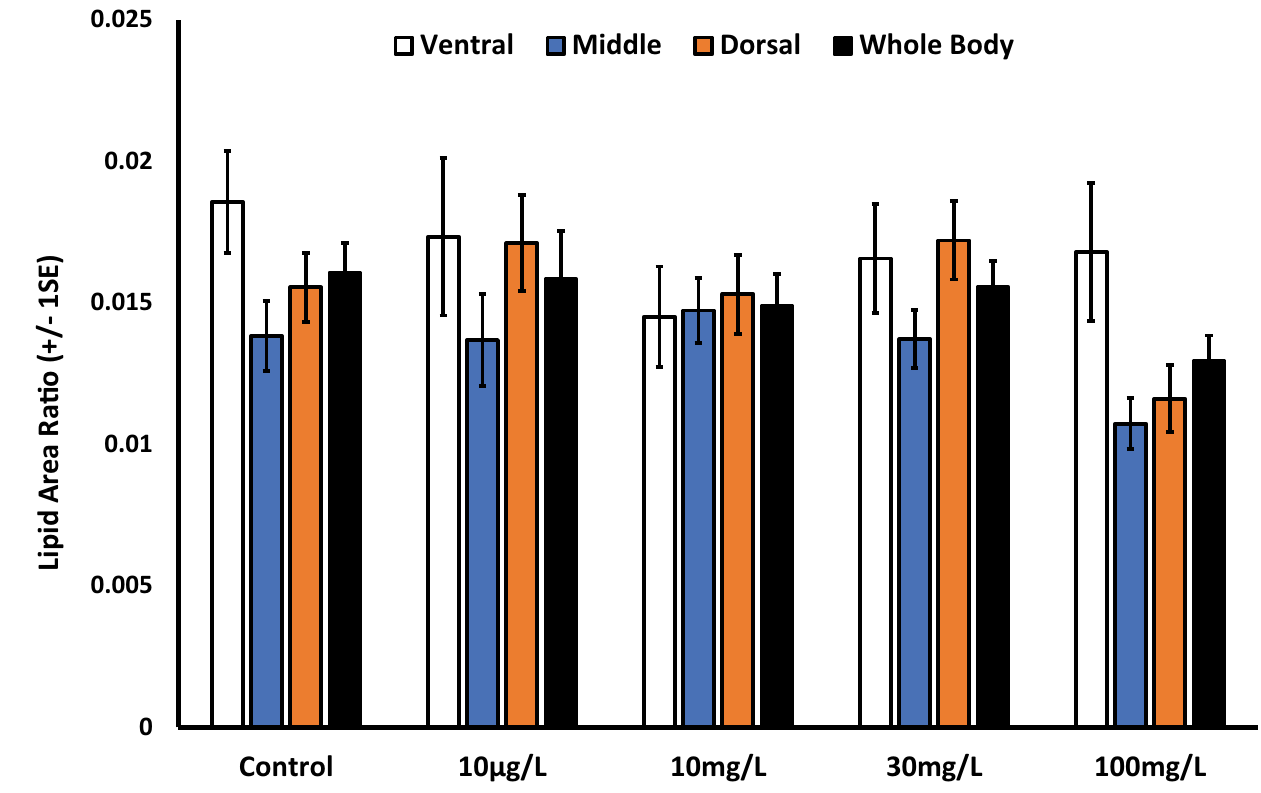
Fig 3. Control zebrafish and perchlorate exposed zebrafish do not differ in lipid content in the ventral, medial or dorsal regions of the body. Whole body lipid ratio is an average across all the sections of the fish.